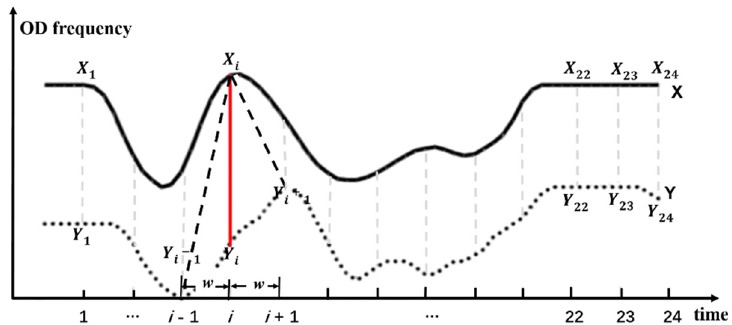
Figure 3. Illustration of the aggregate unit: ( a ) chart of the OD frequency in each direction of the road intersection, ( b ) chart of the distances from the OD points to the nearest road intersection, and ( c ) diagram of the aggregate unit.